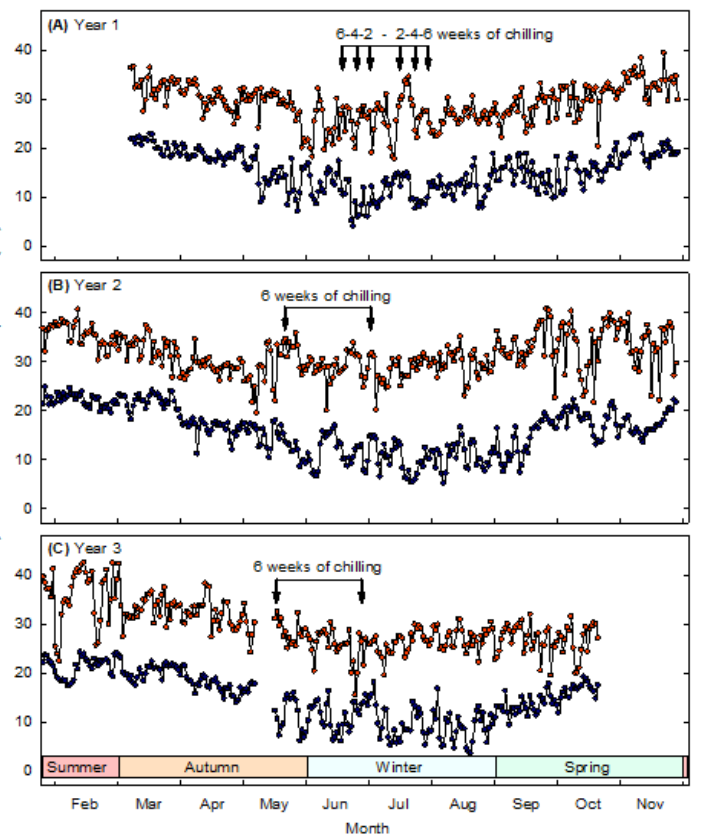
Figure 2. Daily maximum and minimum temperatures experienced by peony plants in the tunnel house in ( A ) Year 1, ( B ) Year 2, and ( C ) Year 3 of the study. Arrows indicate the start and finish